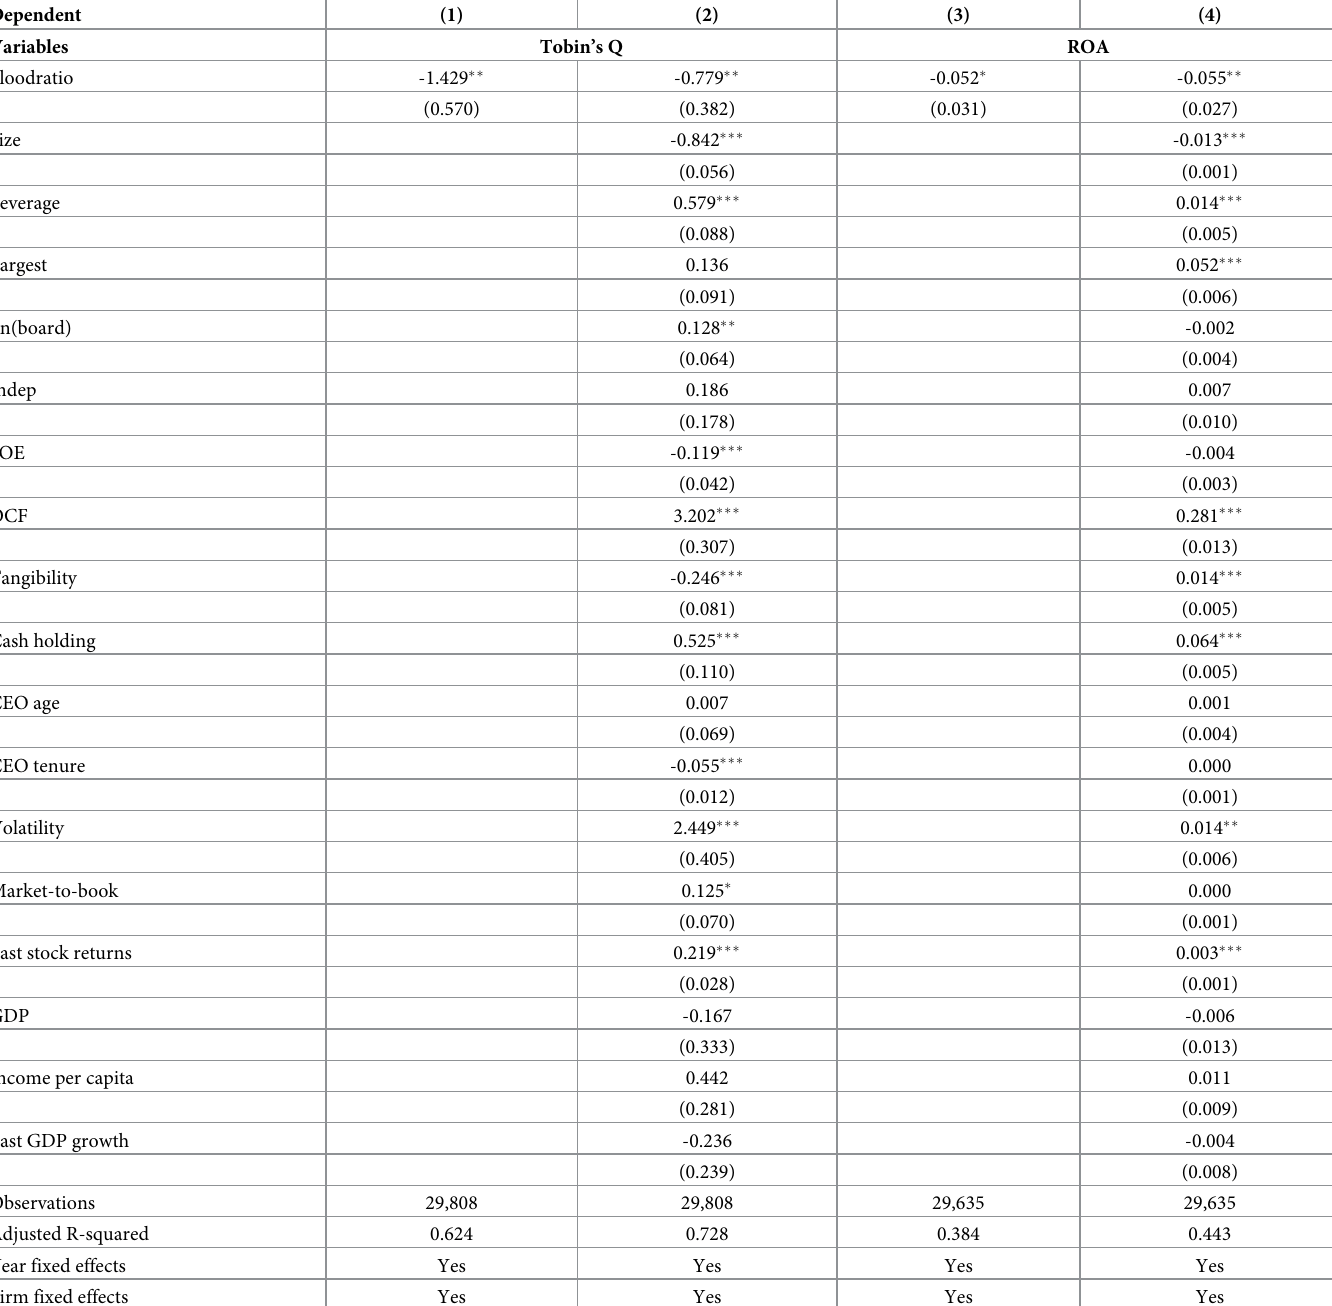
Table 2. Flooding and firm performance. This table reports the results of the effects of flooding on firm performance using various proxies for firm performance, includ- ing Tobin’s Q and ROA , which are measured in year t+ 1. Columns (1) and (3) report the regression results without the control variables and columns (2) and (4) report the regression results with control variables. The key independent variable is Floodratio , which is defined as the ratio of flood area in each city (where the firm’s headquarter is located) to the city’s total area and measured in year t . All of the control variables used in this table are also measured in year t . Variable definitions are in Table A1 in the S1 Appendix. Robust standard errors are clustered at the city-year level and reported in parentheses. � , �� and ��� indicate the significance levels at 10%, 5% and 1%,